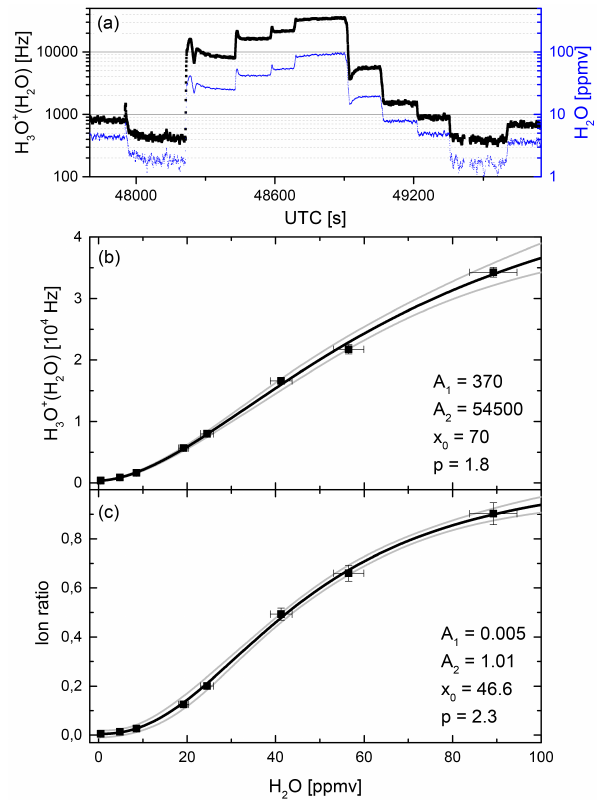
Figure 7. In-flight calibration curves for two different evaluation methods. (a) Time series of the H 3 O + (H 2 O) ( m/z = 37amu) sig- nal for a characteristic calibration sequence. The corresponding wa- ter vapor mixing ratio, calculated from the AIMS-H 2 O count rate, is shown in blue. (b) Count rate on m/z = 37amu vs. H 2 O in the cali- bration gas. In panel (c) the ratio of ion masses ( 19 + 37 + 55 )/( 19 + 32 + 37 + 46 + 55 ) is plotted against H 2 O. The gray curves mark the 95% confidence interval of the respective fit curves, fit parameters are given for both calibration